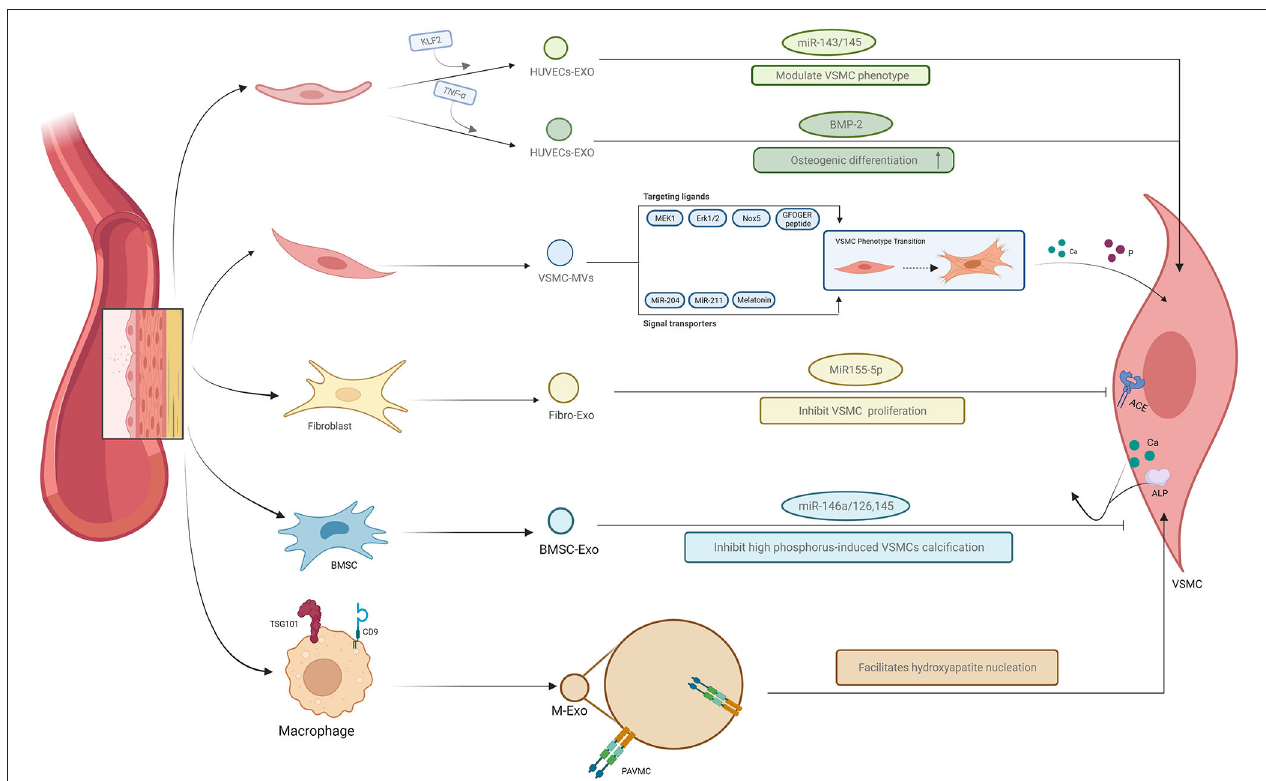
FIGURE 2 | Exosome-mediated crosstalk in the vascular microenvironment. The exosomes derived from different cell populations can facilitate or inhibit vascular calcification via exosome-mediated crosstalk between VSMCs and other cell populations through different molecules, such as miRNAs and bone morphogenetic protein-2 (BMP-2), among